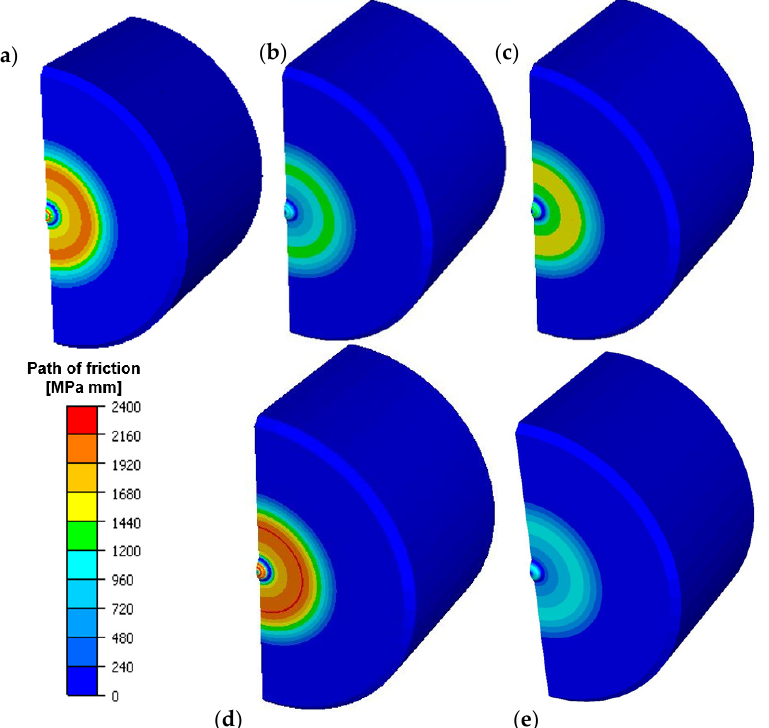
Figure 17. Distributions of the total abrasive wear for the selected simulation variants: ( a ) I, ( b ) II, ( c ) III, ( d ) IV, ( e ) V.